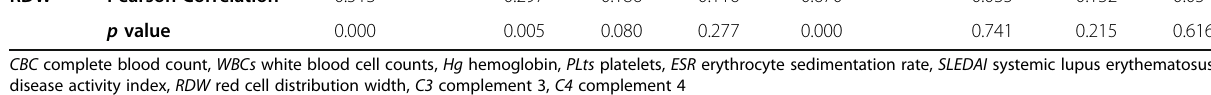
Table 6 Correlation between laboratory parameters and SLEDAI score with ESR, neutrophils and, lymphocytes counts